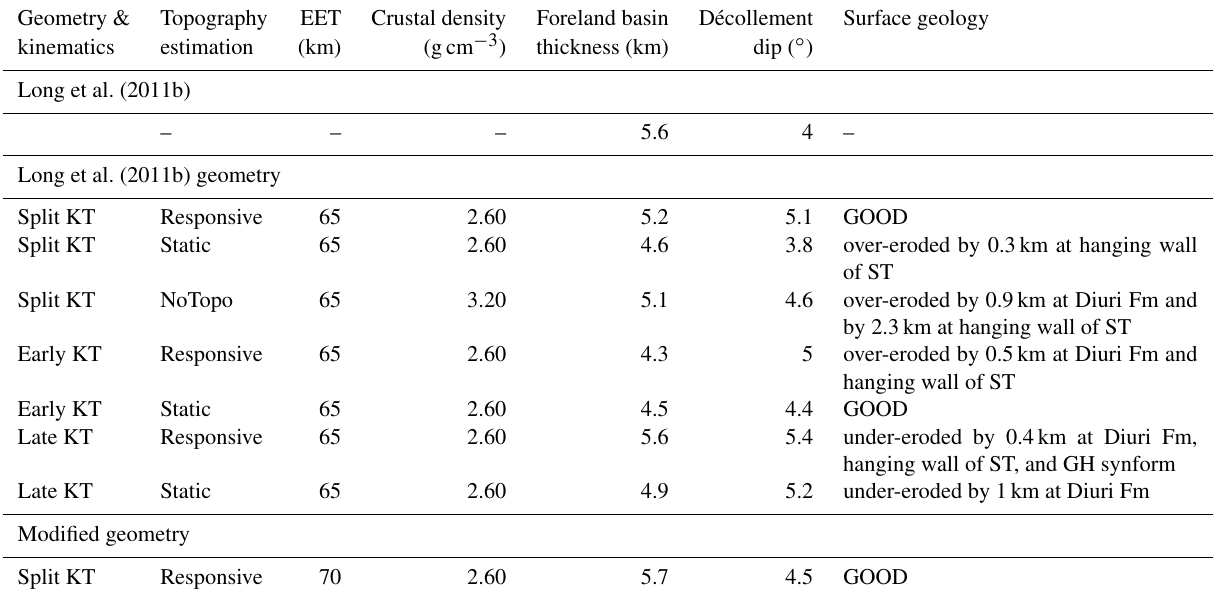
Table 1. Comparison of the geologic constraints of the published Trashigang cross section to the final deformed cross section results of the flexural–kinematic models presented in this study. Geometry